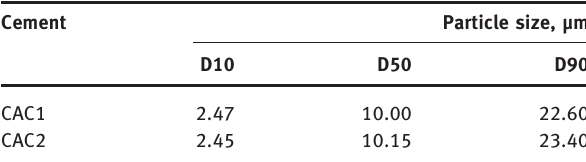
Table 2: Particle size of the cements with and without B 2 O 3 . Cement